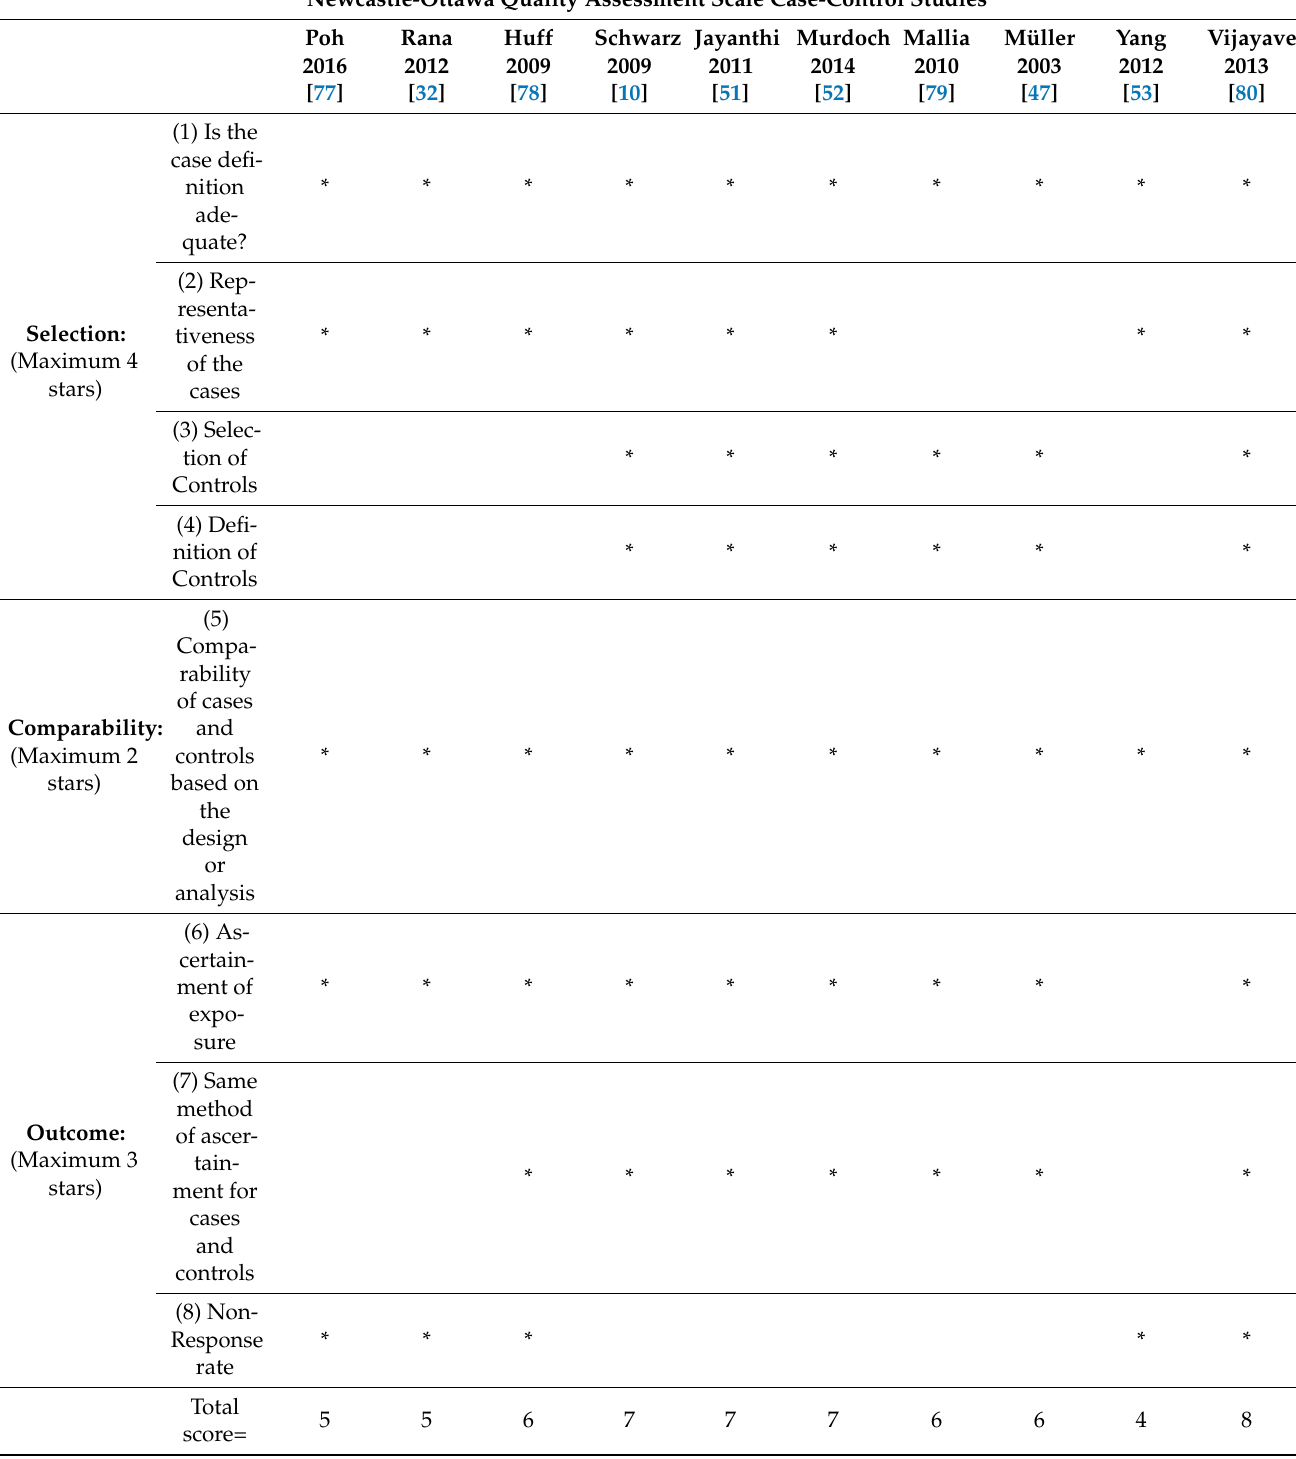
Table 4. Newcastle-Ottawa quality assessment scale case-control